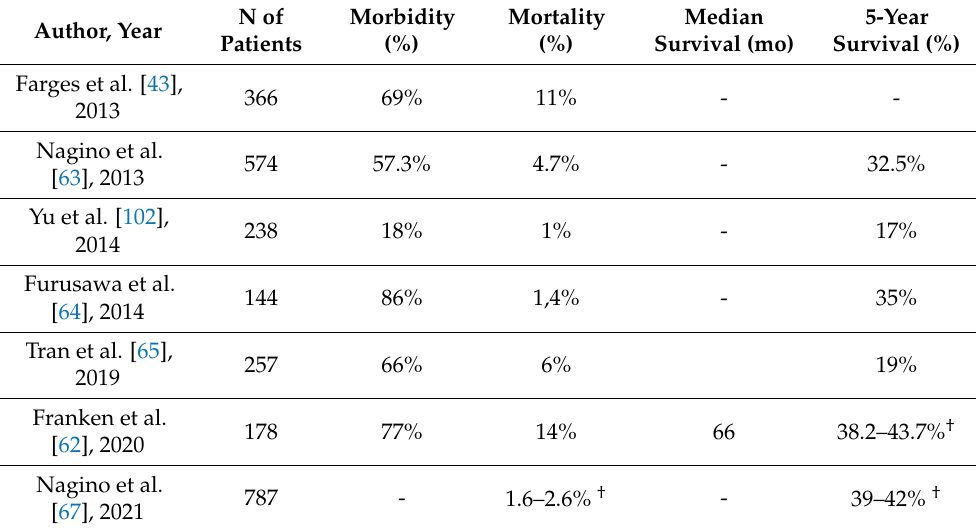
Table 2. Hilar cholangiocarcinoma, post-operative